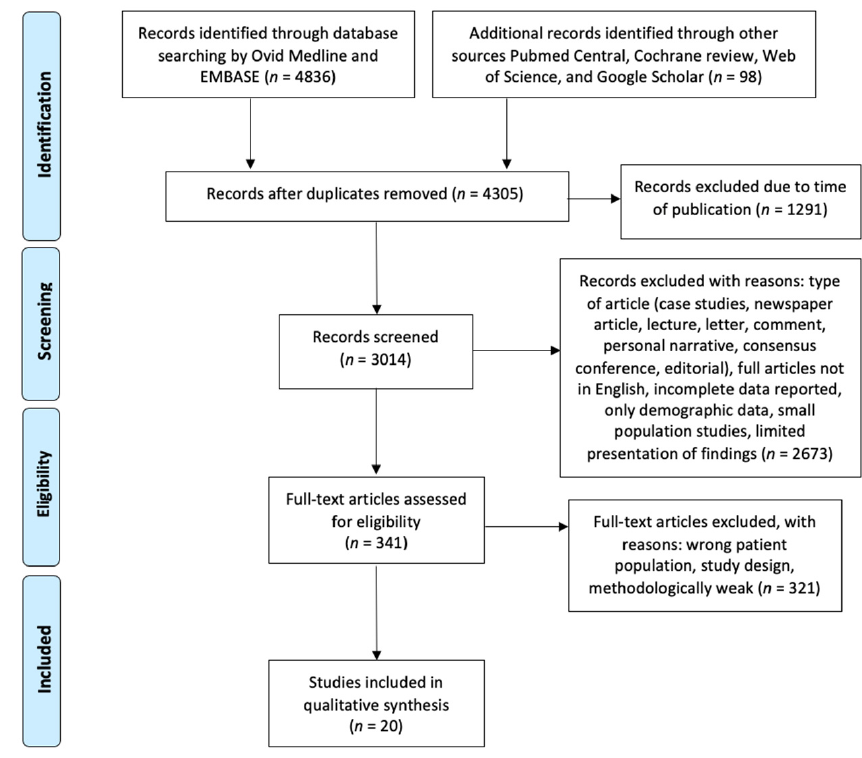
Figure 1. Prisma flow diagram of the systematic search.